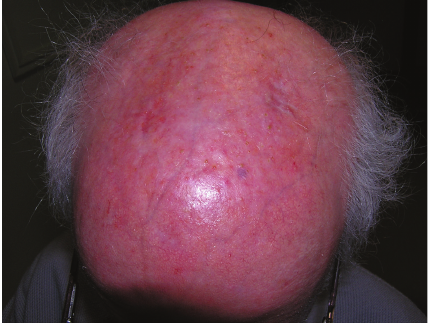
Figure 2: Complete resolution after 2 months of oral steroid